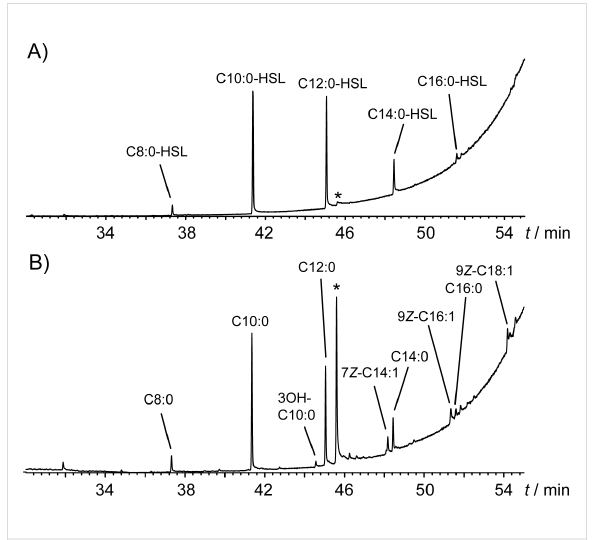
Figure 2: Total ion chromatograms of the extracts from competition experiments using recombinant PgaI 2 from P. inhibens with SAM and a mixture of equally concentrated substrates A) 10a – h (saturated chains C 4 –C 18 ) and B) 10a – i , 11a – c and 12 . Prominent contaminants are indicated by